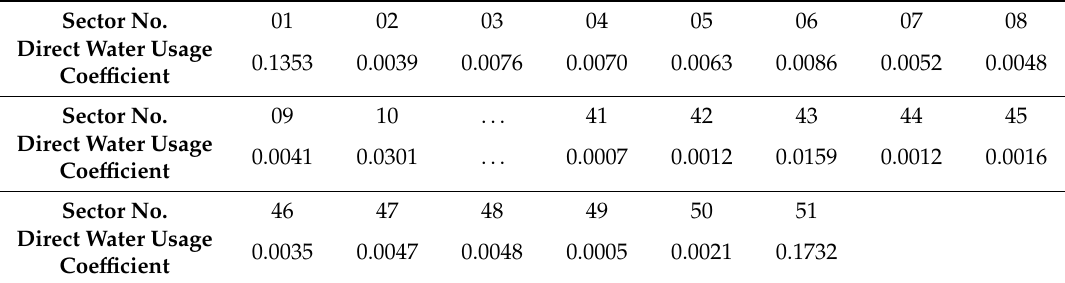
Table A4. The direct water usage coe ffi cient table of the 51 sectors.